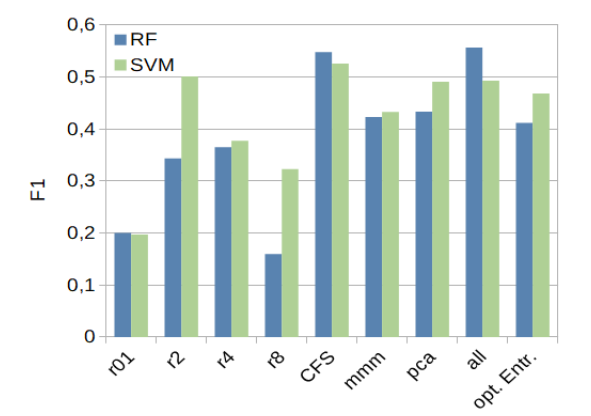
Figure 9. F1 - Ball-shaped neighbourhood